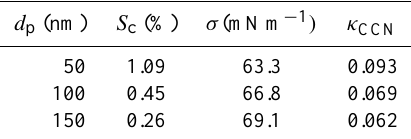
Table 6. Critical supersaturation ( S c ) , surface tension at activation ( σ) and hygroscopicity parameter ( κ CCN ) for a particle consisting of 30% levoglucosan, 5% fulvic acid and 65% insoluble material at various particle diameters ( d p )